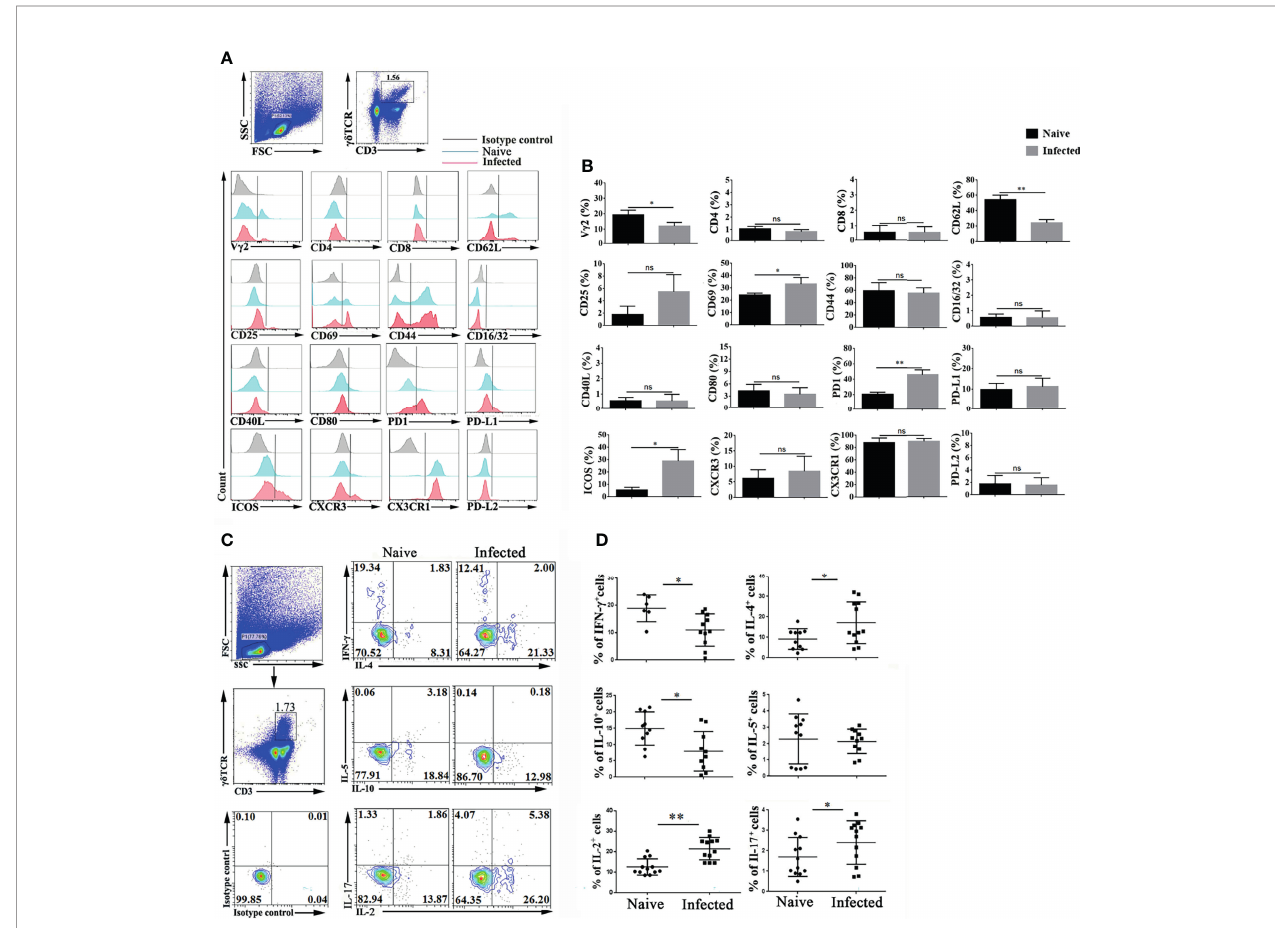
FIGURE 2 | Plasmodium infection induced splenic gd T cell activation and differentiation. (A, B) Splenocytes were separated from naive and infected mice (14 days post infection) and then stained with monoclonal antibodies against mouse CD3, gd TCR, V g 2, CD4, CD8, CD62 L, CD25, CD69, CD44, CD16/32, CD40 L, CD80, PD-1, PD-L1, PD-L2, ICOS, CXCR3 and CX3CR1 after cell surface staining. (A) A representative result of three independent experiments is shown. (B) The average expression of different surface molecules on gd T cells was calculated by FCM data. (C, D) Isolated splenocytes were stimulated by PMA and ionomycin, and the expression levels of cytokines (IFN- g , IL-4, IL-5, IL-10, IL-2, and IL-17) were detected in CD3 + gd TCR + cells after intracellular staining. (C) A representative of three independent experiments is shown. (D) The average expression levels of different cytokines on gd T cells were calculated by FCM data. The average of three independent experiments with 3-5 mice per group was shown and repeated three times with similar results. The error bars are SD, * P < 0.05, ** P < 0.01. ns, no signi fi